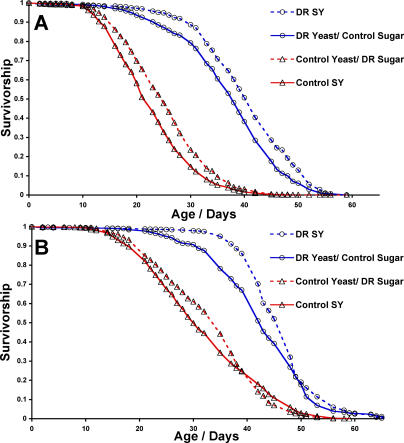
Survivorship (lx) Analysis of Life Span of Female Drosophila on Different Food RegimesColour/Symbol of the curves shows yeast level while the line type represents sugar levels in the respective foods. (A) and (B) are independent repeats. In both cases, changing caloric content of the food by altering yeast levels had a much greater effect on life span than that seen when the same change in caloric content was brought about by manipulating sugar levels.